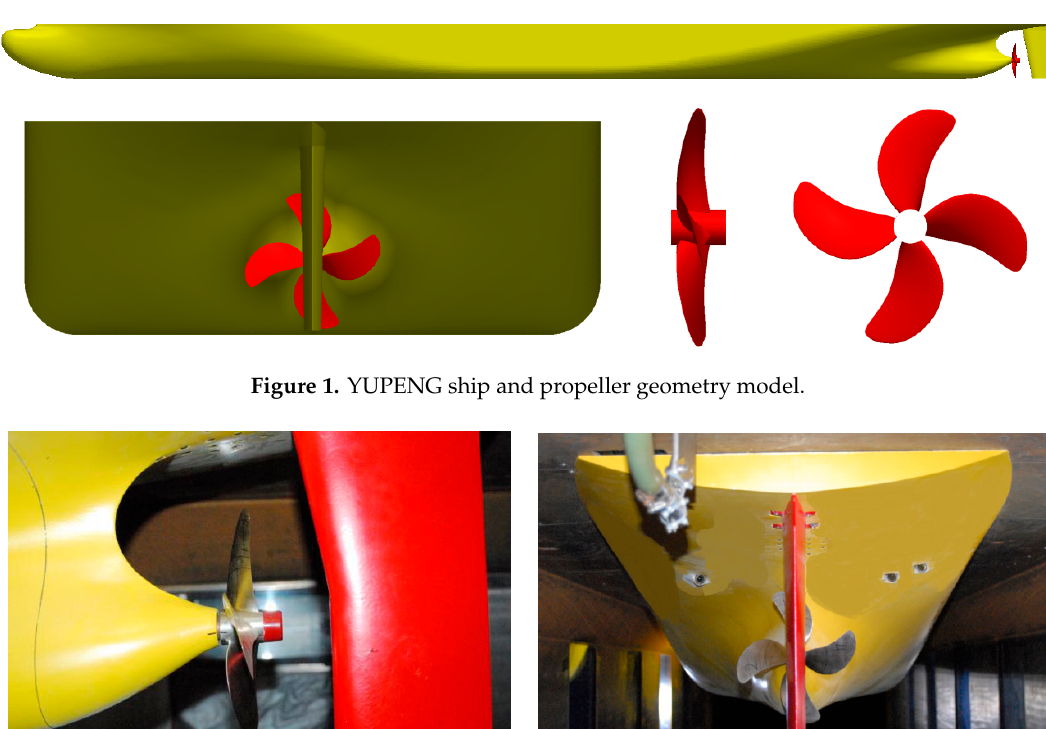
Figure 2. The benchmark test set.